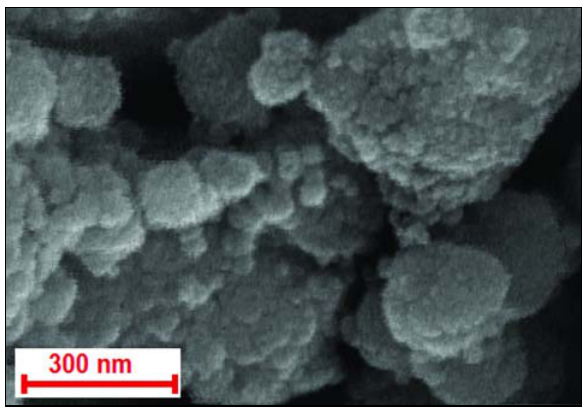
O nanoparticles. 3 4